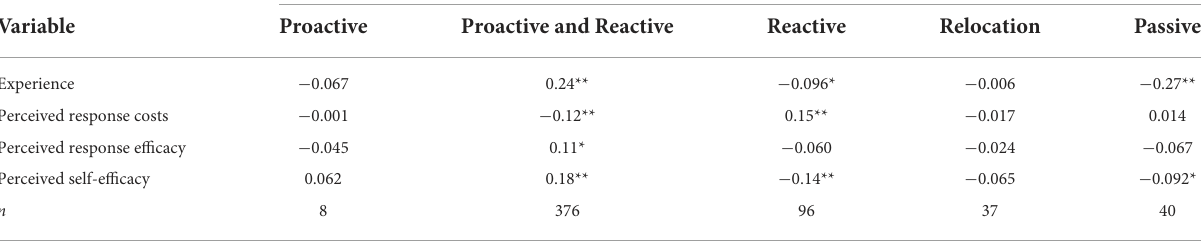
TABLE 4 Spearman-Rho-coefficients for possible drivers of precautionary behavior and adaptation strategies ( n = 557, data: businesses in Germany damaged by the 2013 flood).